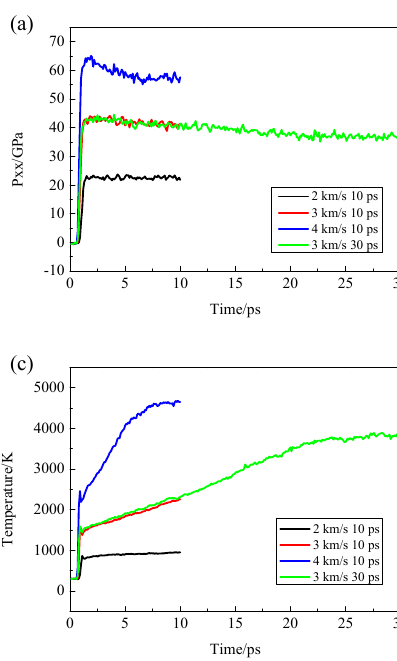
Figure 3. Change of pressure ( a ), density ( b ) and temperature ( c ) of CL-20/TNT cocrystal with time under di ff erent impact velocities.